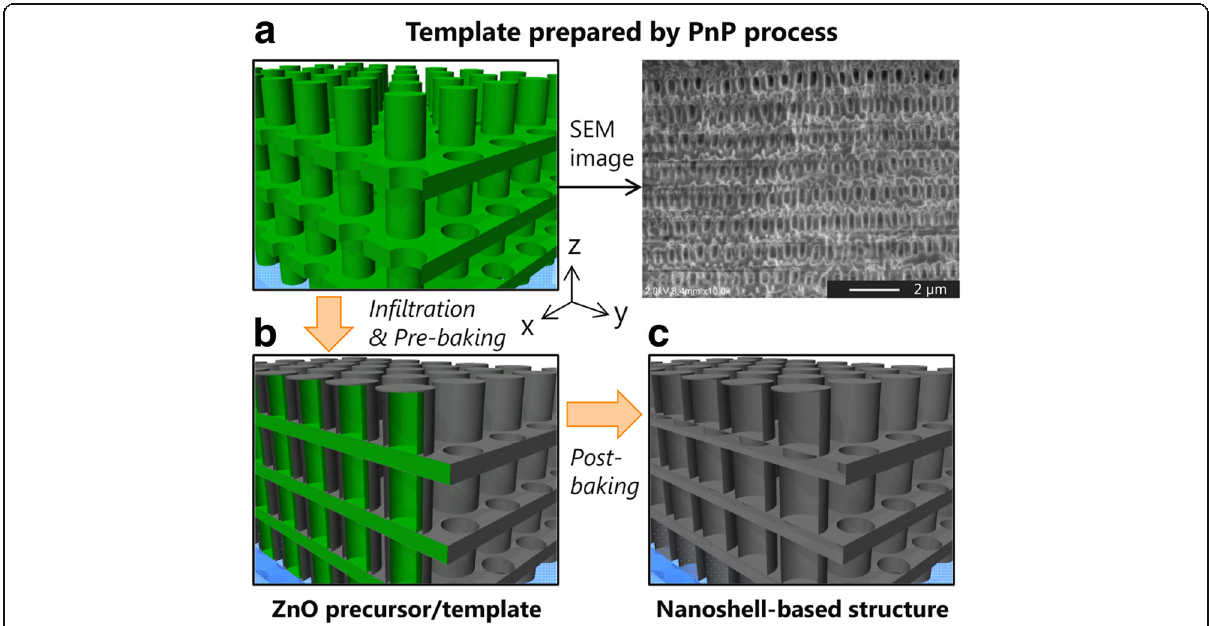
Fig. 1 Schematic diagram of the procedure using infiltration process with solution-derived ZnO for nanoshell-based 3D structures. a Preparation of template by PnP process. b Infiltration of ZnO precursor solution into the template and pre-baking several times, and c Post-baking for template